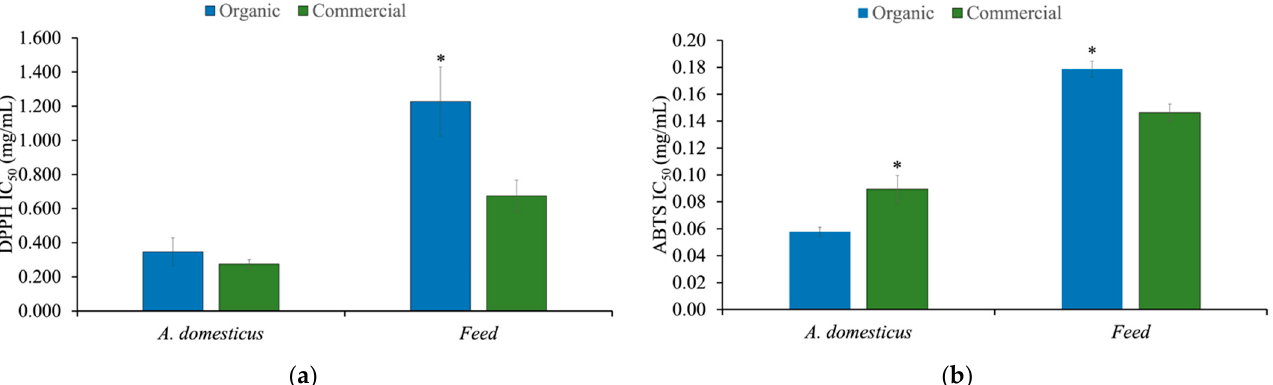
Figure 1. Antioxidant activity assays of extracts of A. domesticus (organic Acheta and commercial Acheta ) and feed (organic feed and commercial feed): ( a ) DPPH radical scavenging activity (IC 50 value, mg extract/mL); ( b ) ABTS radical scavenging activity (IC 50 value, mg extract/mL). Asterisk (*) indicates significant difference ( p < 0.05) between A. domesticus and feed extracts, respectively.